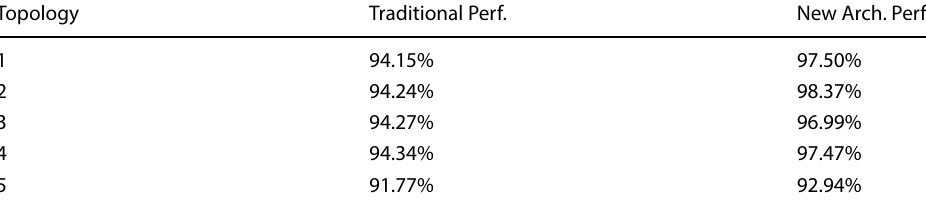
Table 4 Performances— second